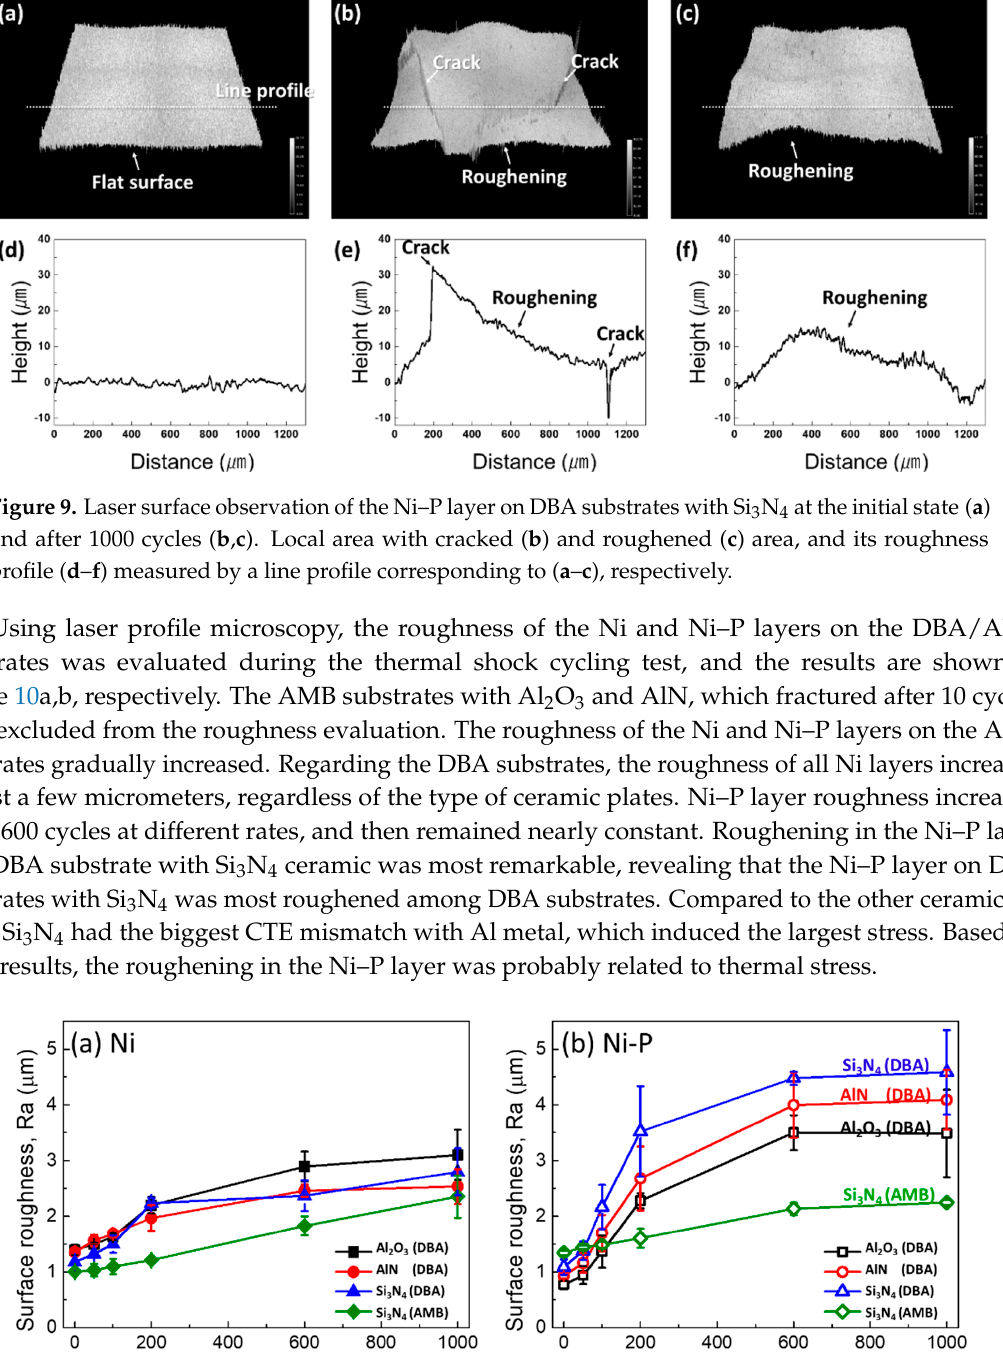
Figure 8. SAT observation of the surface morphology of the Ni–P layer on DBA substrates with Al 2 O 3